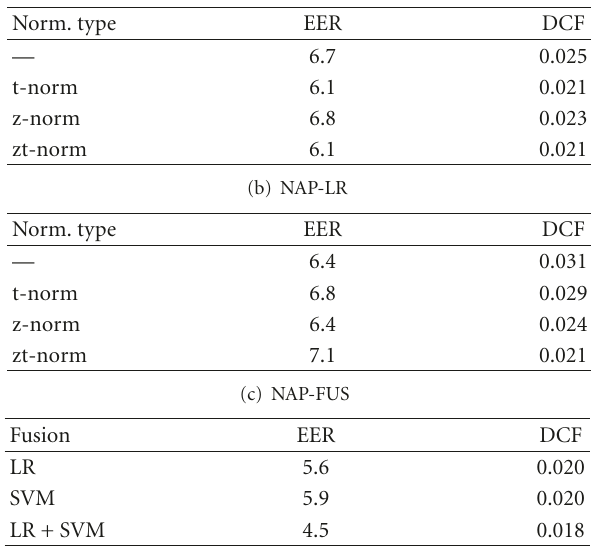
Table 3: Speaker verification results of the NAP-based systems. The EER and DCF figures for (a) the SVM and (b) LR decision criteria as well as (c) their fusion are